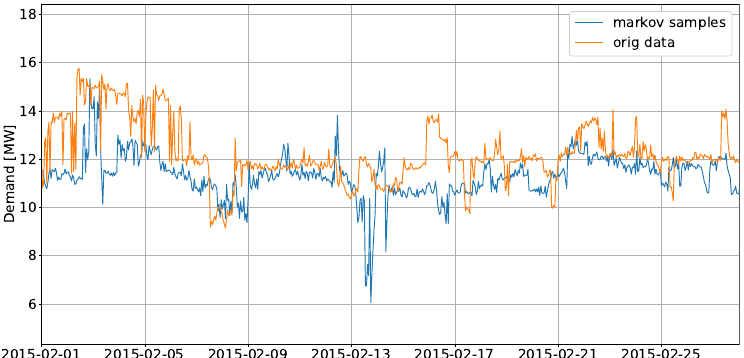
Figure 9. Sampling of the GHMM (blue) together with the original time series (orange).